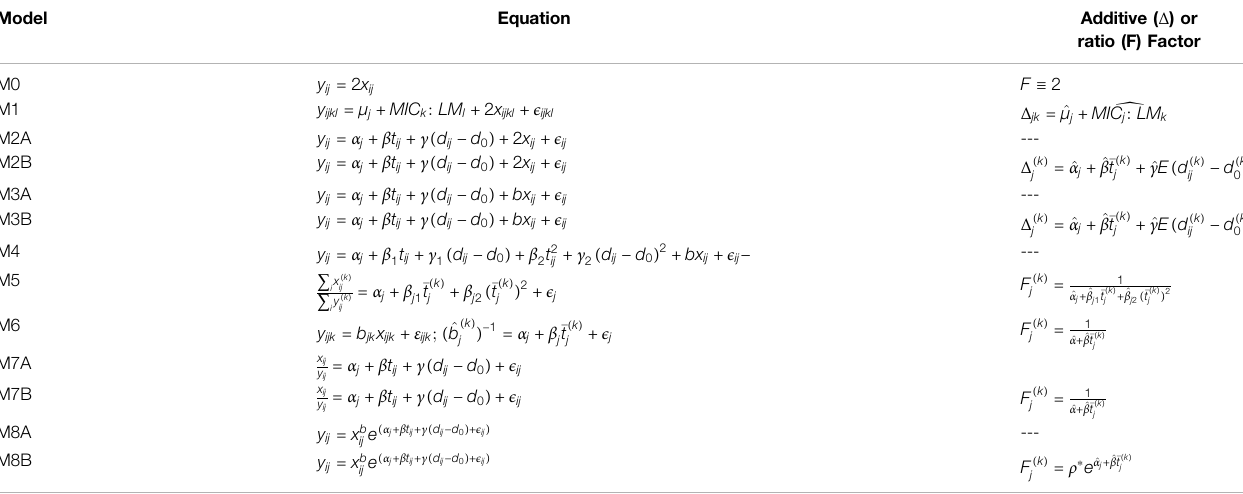
TABLE 2 | Statistical methods and correction factors used in the present study a,b,c .